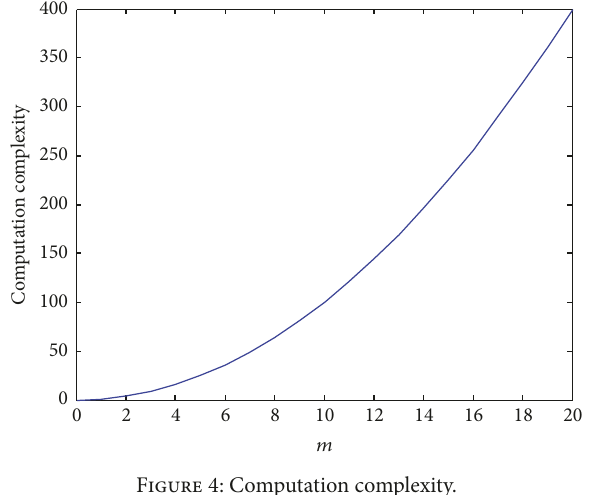
Figure 4: Computation complexity.